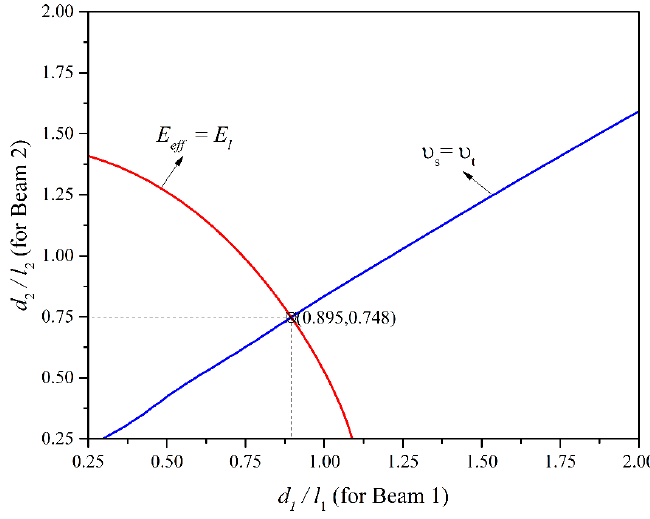
Figure 10. Calibrated geometrical values for d 1 / l and d 2 / l are assigned to, respectively, Beams 1 and 2 in the proposed lattice model.